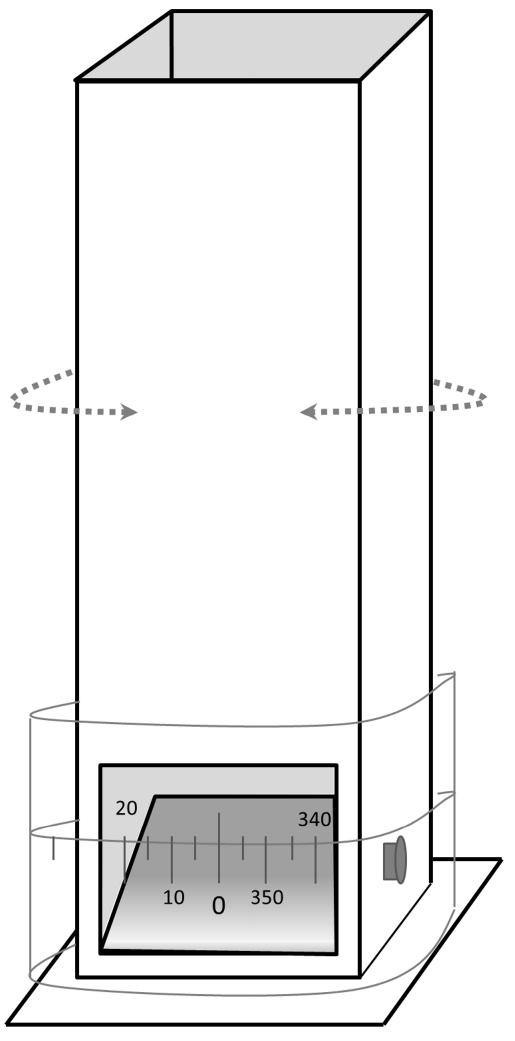
Figure 2. Inverted periscope used for the estimation of birds’ visibility from the